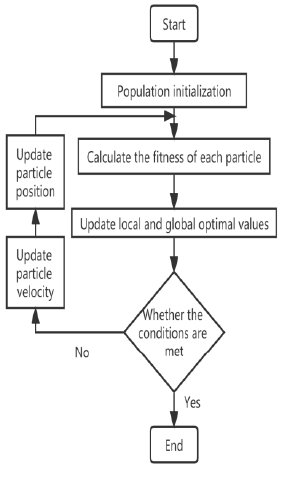
Figure 10. PSO optimization algorithm flow.